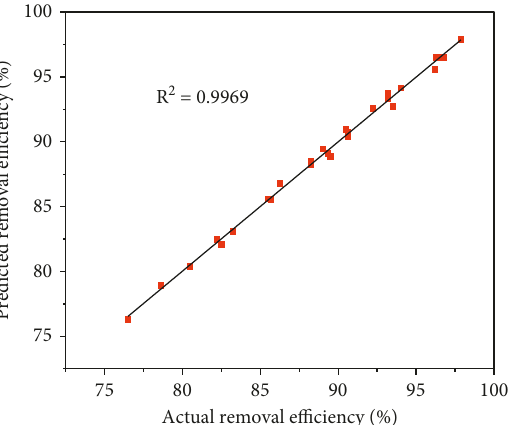
Figure 10: Experimental and predicted Cr(VI) ion removal efficiency by the model for the nanocomposite (BMNC)